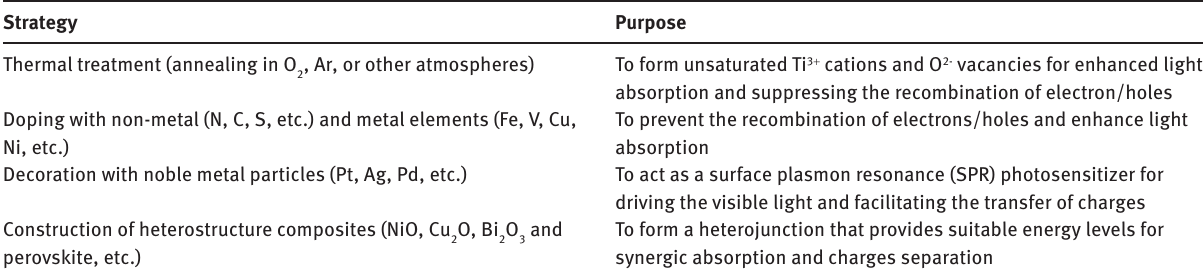
Table 2: Various modification strategies and corresponding purposes.